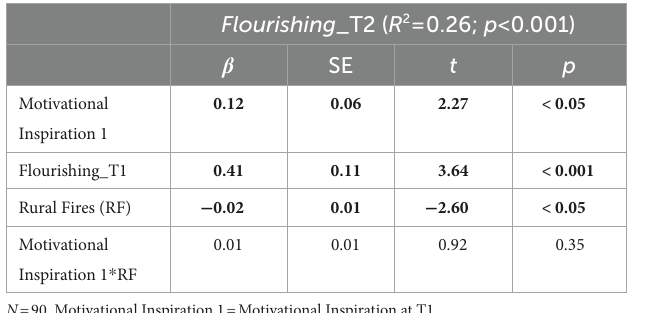
TABLE 3 Analysis of the Effect and Moderation between the Variables under Study – Motivational Inspiration dimension.